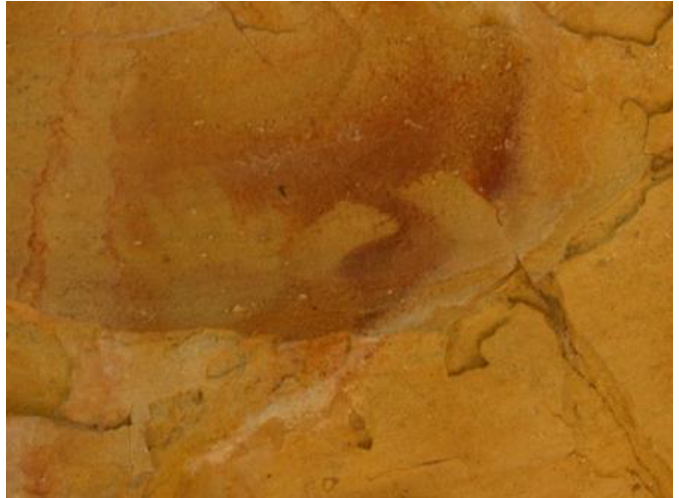
Figure 19. Baby’s feet stencils, Mudgee, New South Wales,